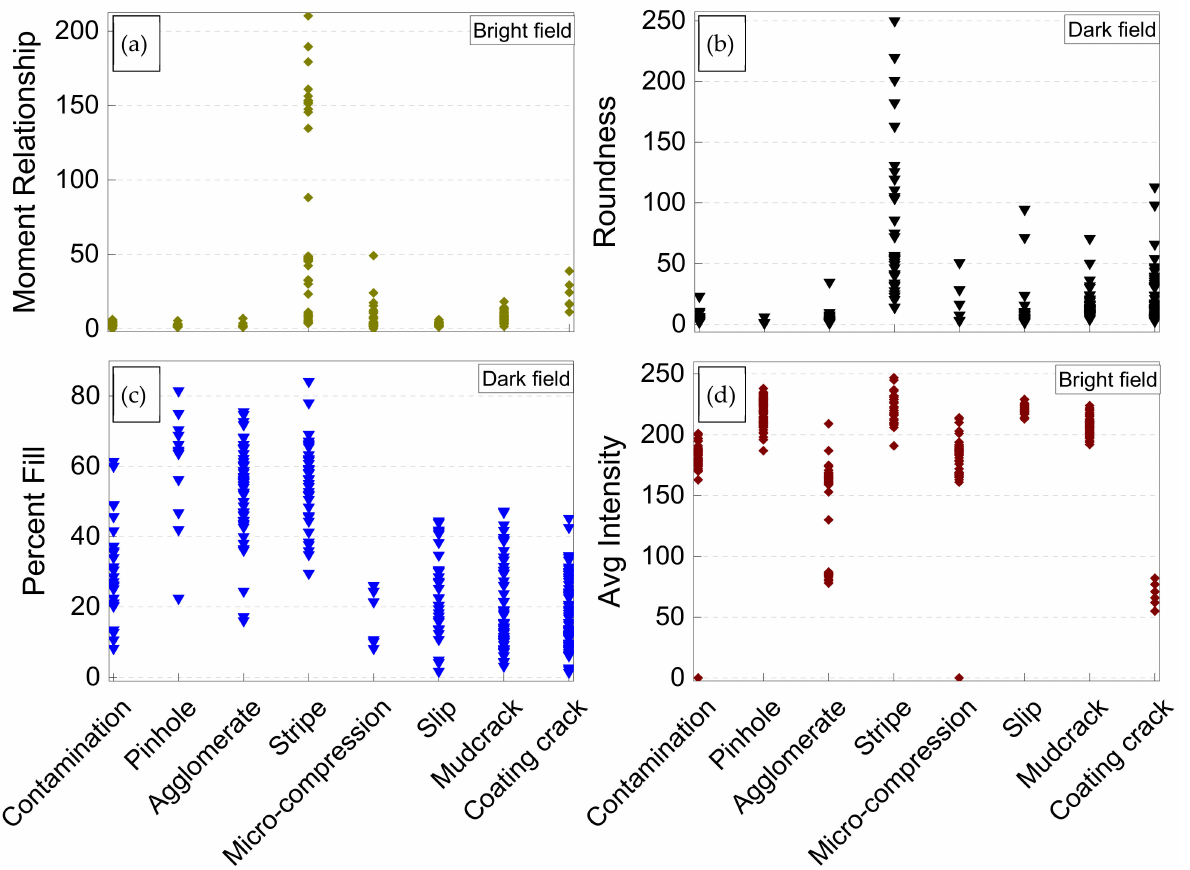
Figure 5. Examples of defect picture features for different defect classes: ( a ) Moment Relationship, ( b ) Roundness, ( c ) Percent Fill, ( d ) Average